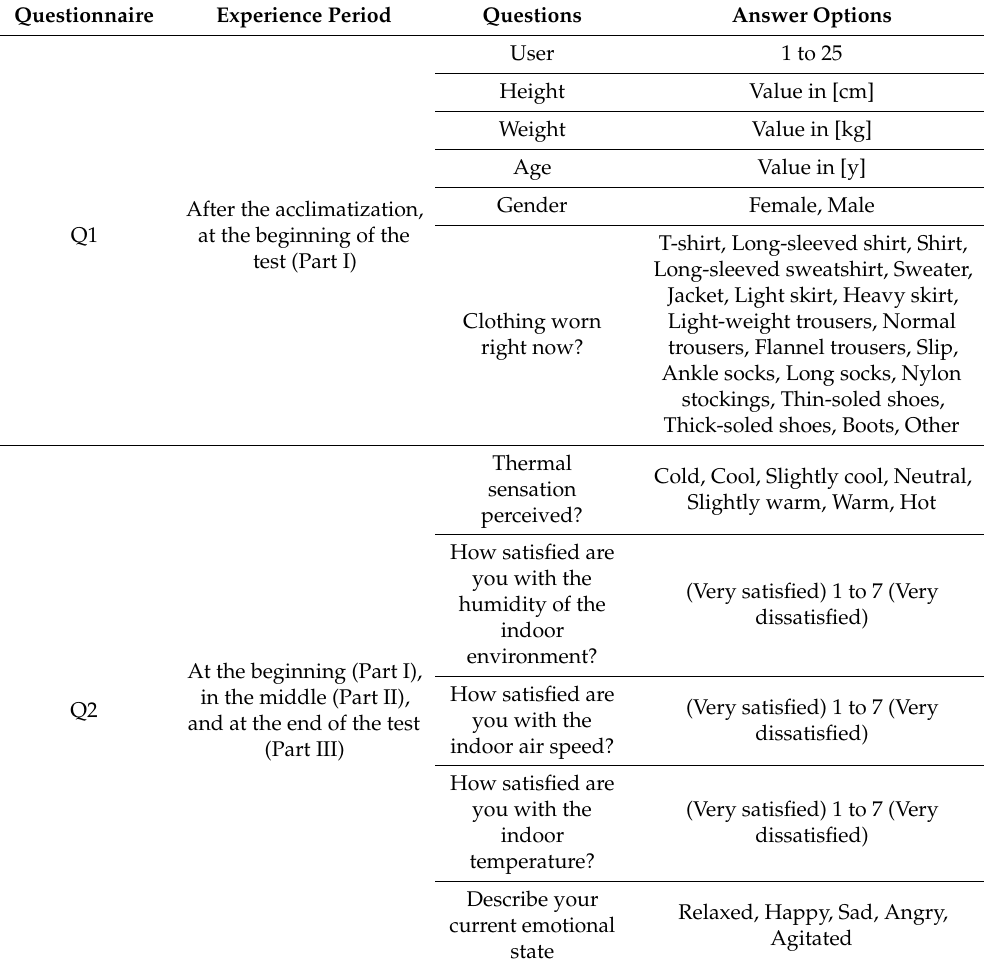
Table 2. Questions of the web-based